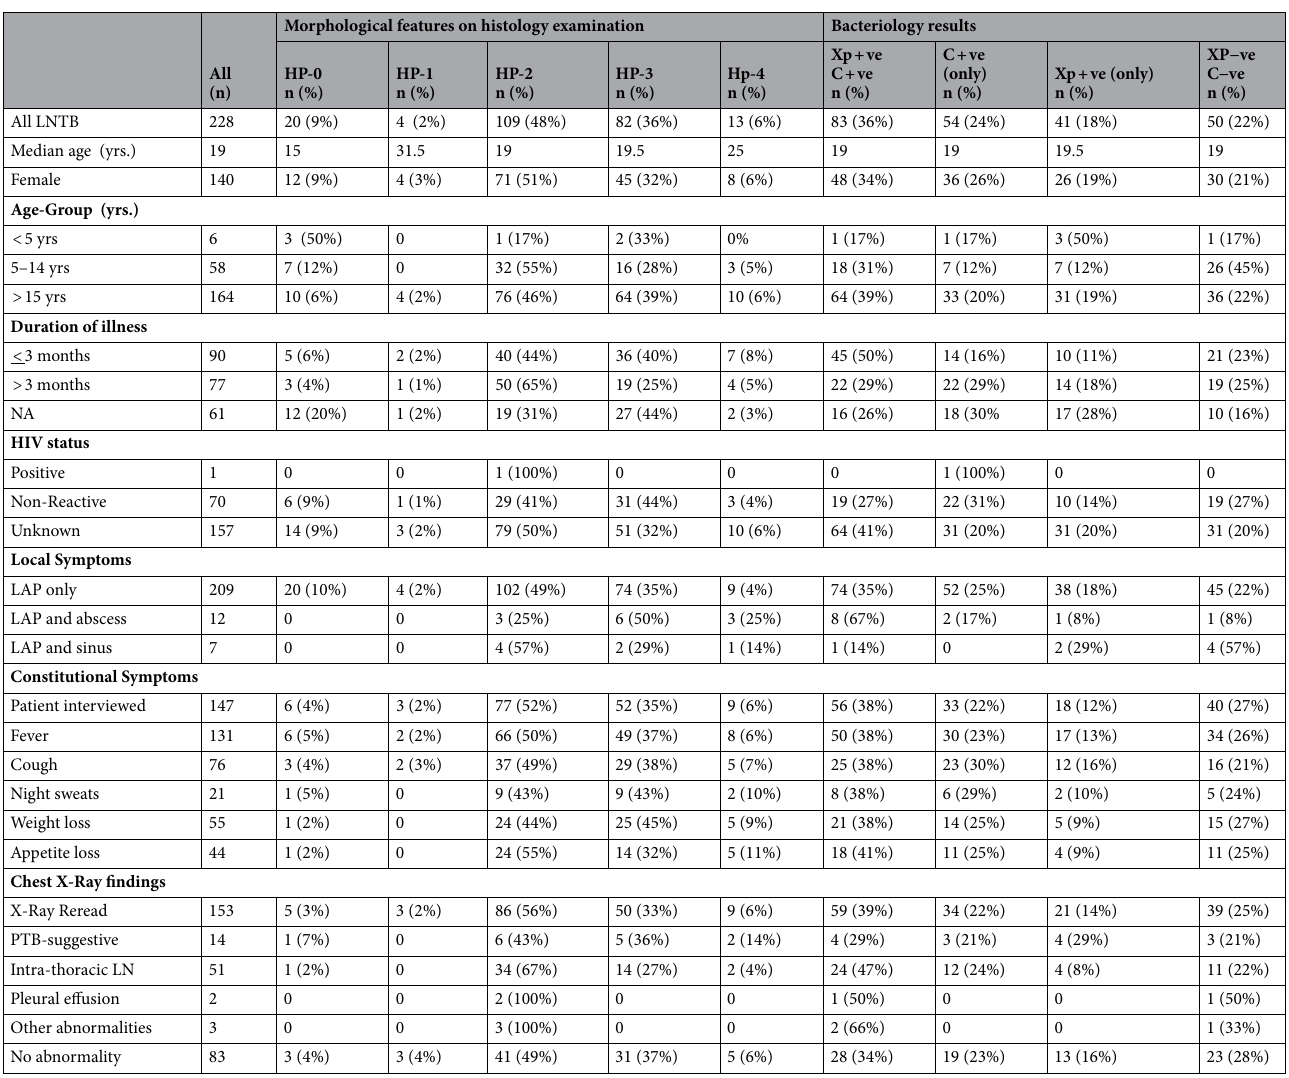
Table 1. Demographic characteristics and clinical features of lymph node tuberculosis patients and results of histopathology and bacteriology examination. HP-0: histological, not suggestive TB, HP-1: Well-formed granulomas no necrosis, HP-2: well-formed granuloma with necrosis, HP-3: ill-formed granulomas with necrosis, HP-4: Caseous necrosis only. LAP: Lymphadenopathy, XP: Xpert MTB/RIF, C: culture, LN: